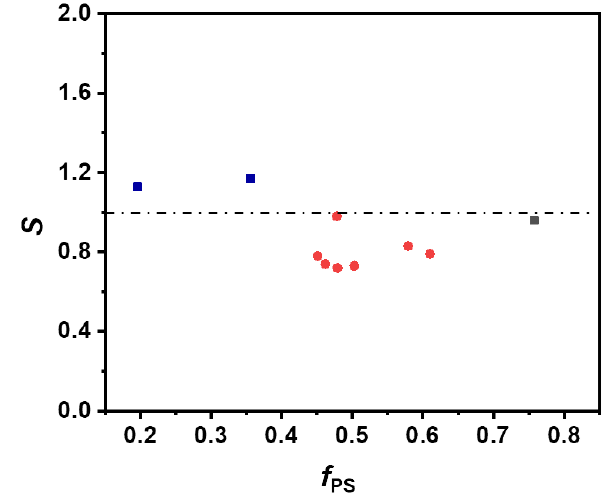
Figure 6. Plot of stretching ratios for polystyrene chains ( S ) versus f PS for all S- b -F samples. Black square, HEX; red dot, LAM; and blue square, iHEX.